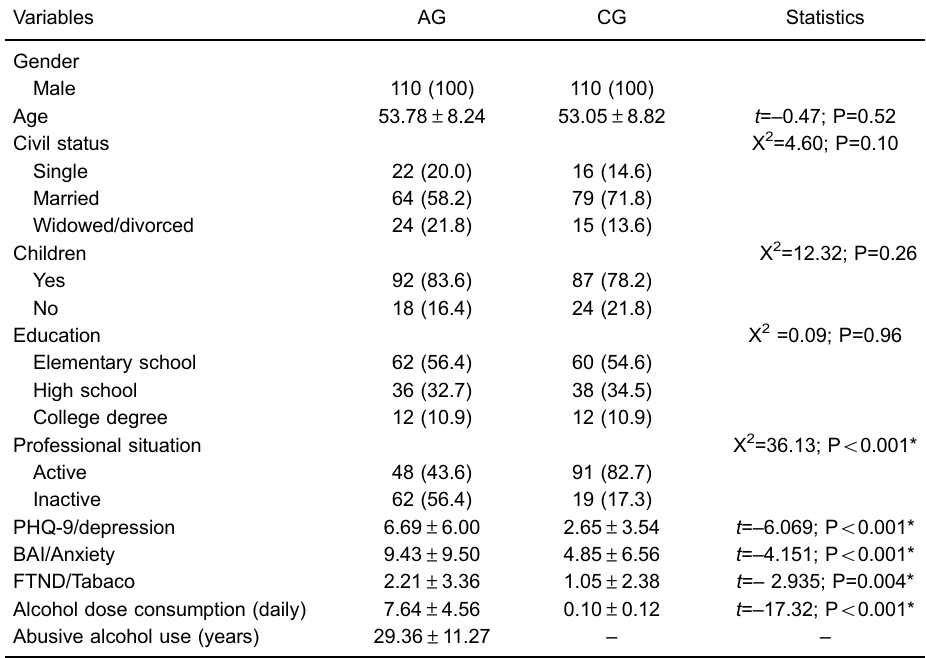
Table 1. Socio-demographic and clinical features of the alcoholic group (AG) and the control group (CG). Variables